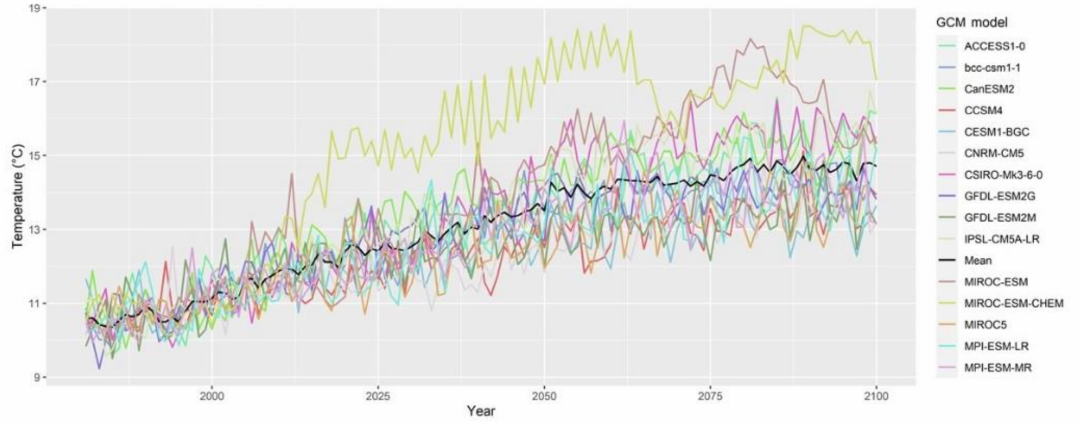
Figure 20. Minimum annual average temperature simulated by climate models, corrected and scaled for the Devil’s Creek, 1981–2100 term, RCP4.5 emission scenario. The black line represents the averaged ensemble of 15 GCMs.